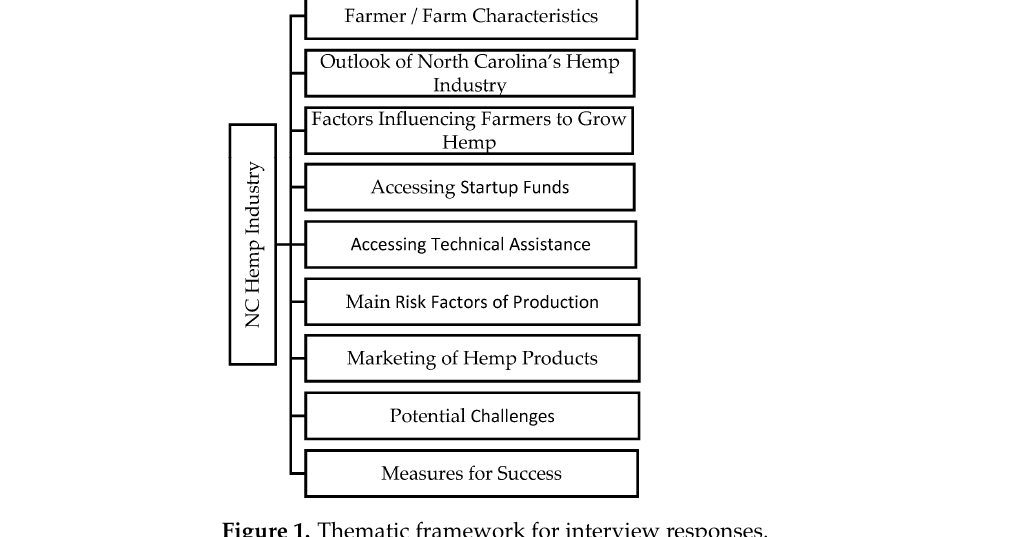
Figure 1. Thematic framework for interview responses.